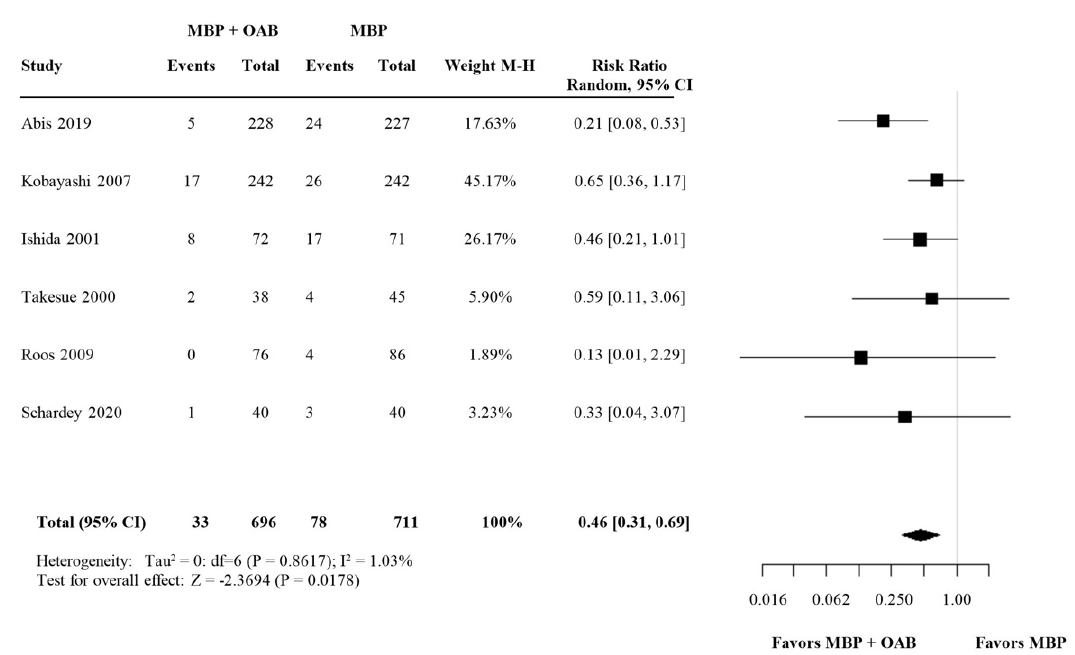
Figure 3. Forest plot comparing SSI rate for patients receiving OABs in addition to MBP and i.v. antibiotic prophylaxis versus MBP with i.v. antibiotic prophylaxis. A random effects model was used to perform the meta-analysis and risk ratios are quoted including 95% confidence intervals.